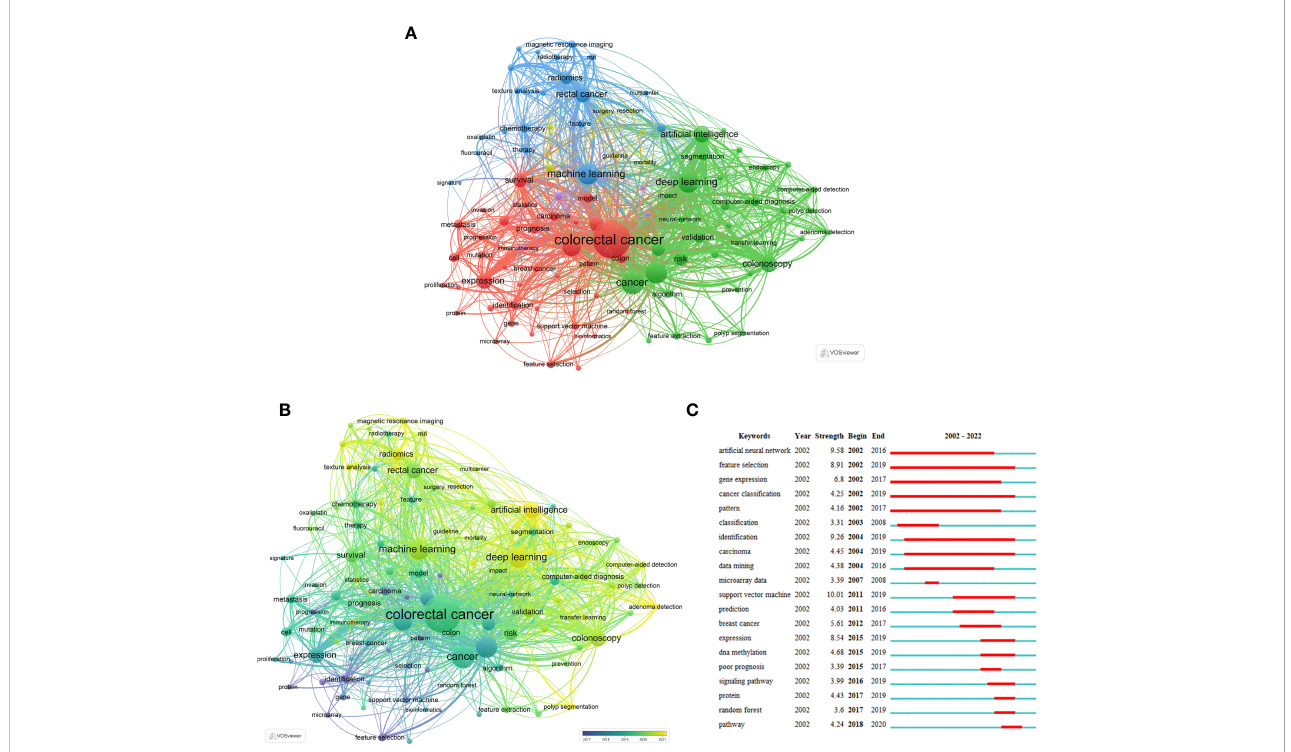
FIGURE 6 Co-occurrence analysis of keywords (The node size represents the frequency of keywords, the line between nodes represents two keywords appearing in the same document at the same time.). (A) Clustering view of keywords co-occurrence analysis (The node color represents keyword clustering.). (B) Temporal view of keywords co-occurrence analysis (The node color represents the average year of keyword occurrence.). (C) The top 20 burst words.